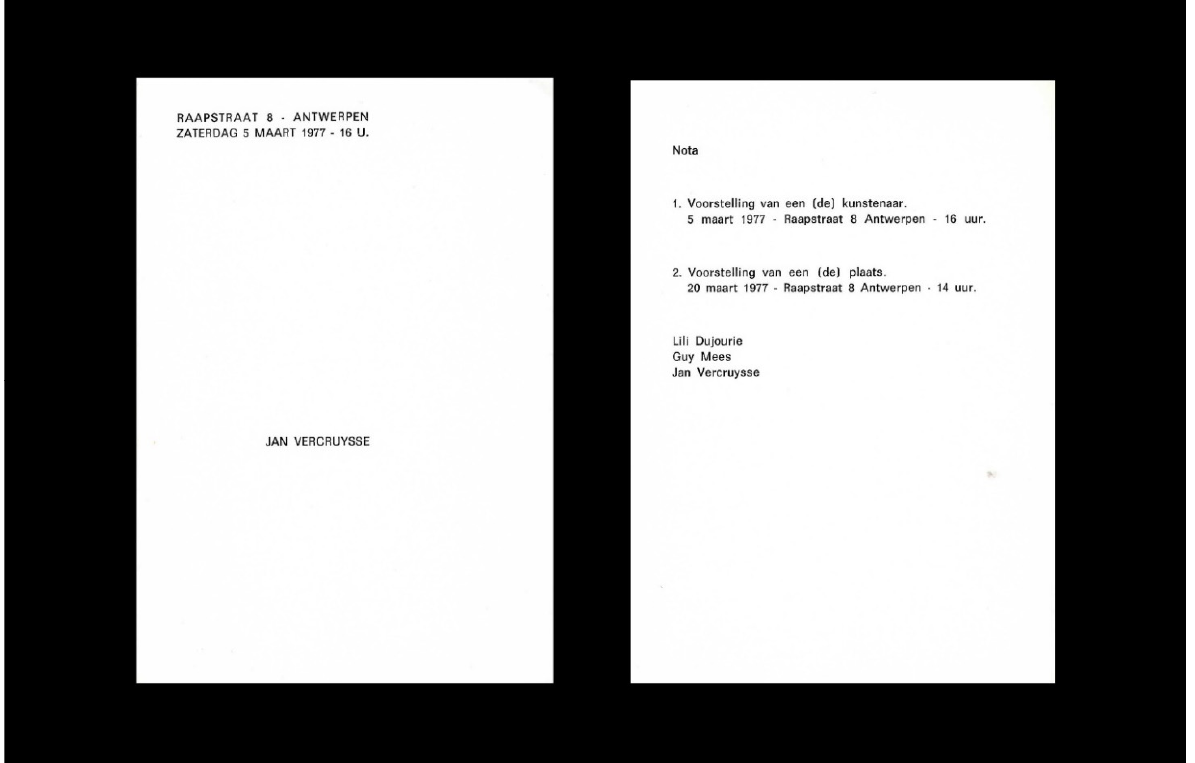
Figure 3. Two invitation cards for the event “Voorstelling van een (de) kunstenaar” 5 March 1977, Raapstraat 8, Antwerp. (Brussels: Jan Vercruysse Foundation). (Reprinted with permission from Jan Vercruysse